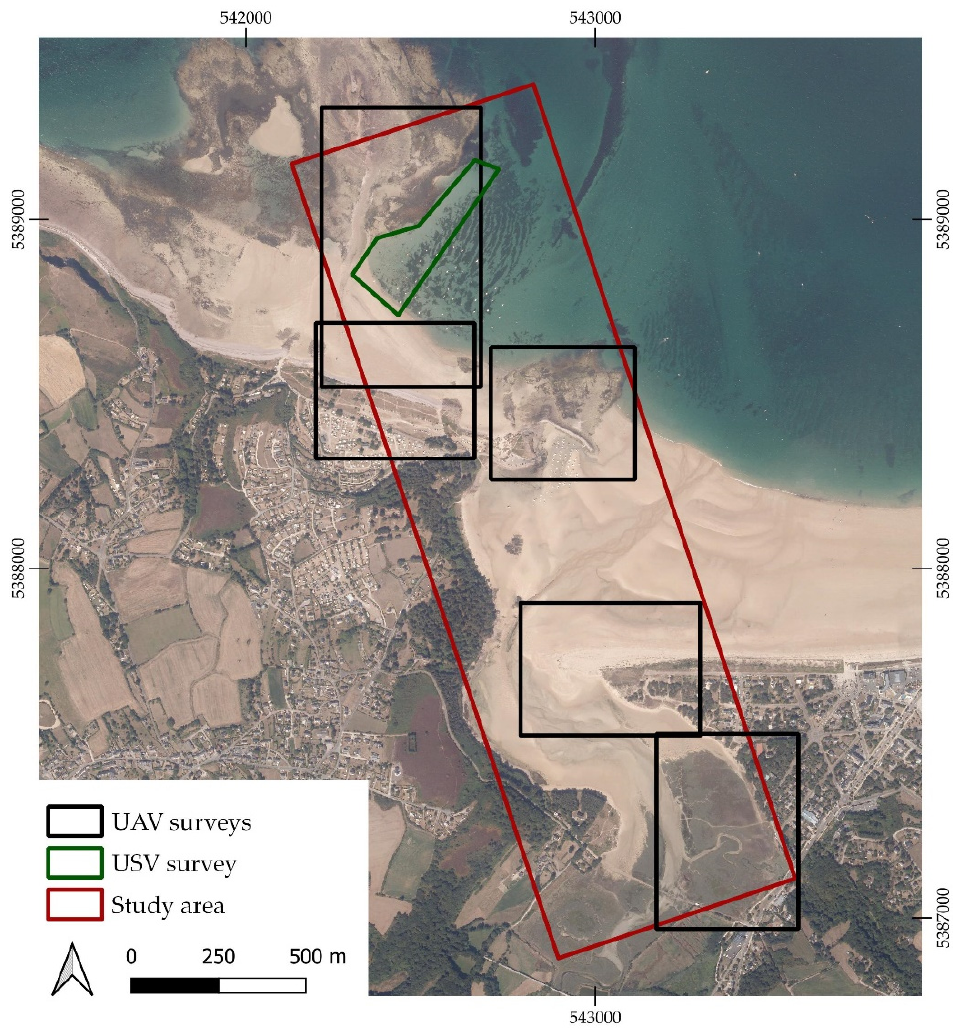
Figure 3. Ground truth data spatial coverage (datum: WGS 84; projection: UTM 30N).